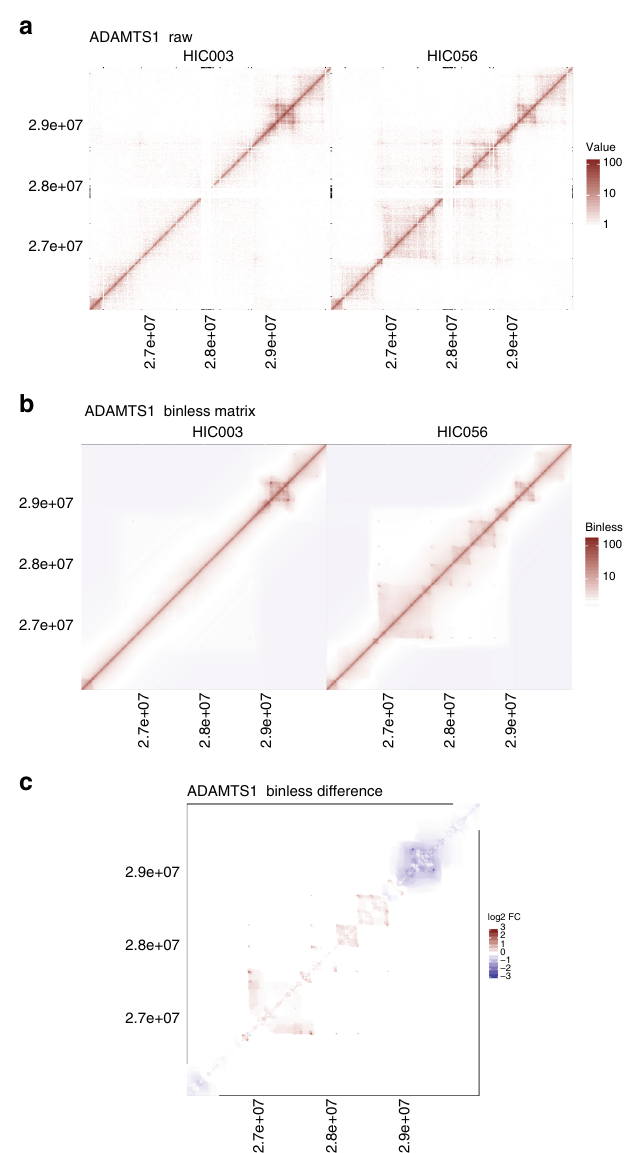
Fig. 5 Example of difference calculations with Binless. ADAMTS1